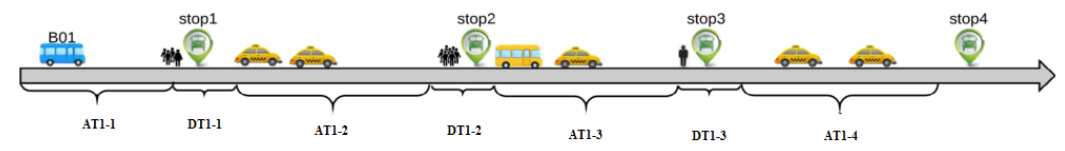
Figure 1. Examples of bus and taxi traveling process.